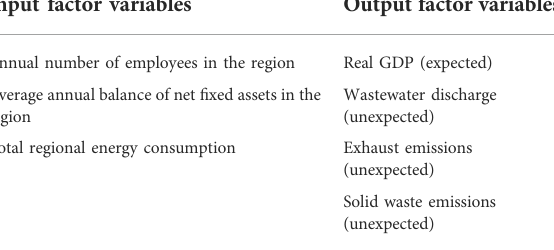
TABLE 1 Input and output variables based on the SBM-GML